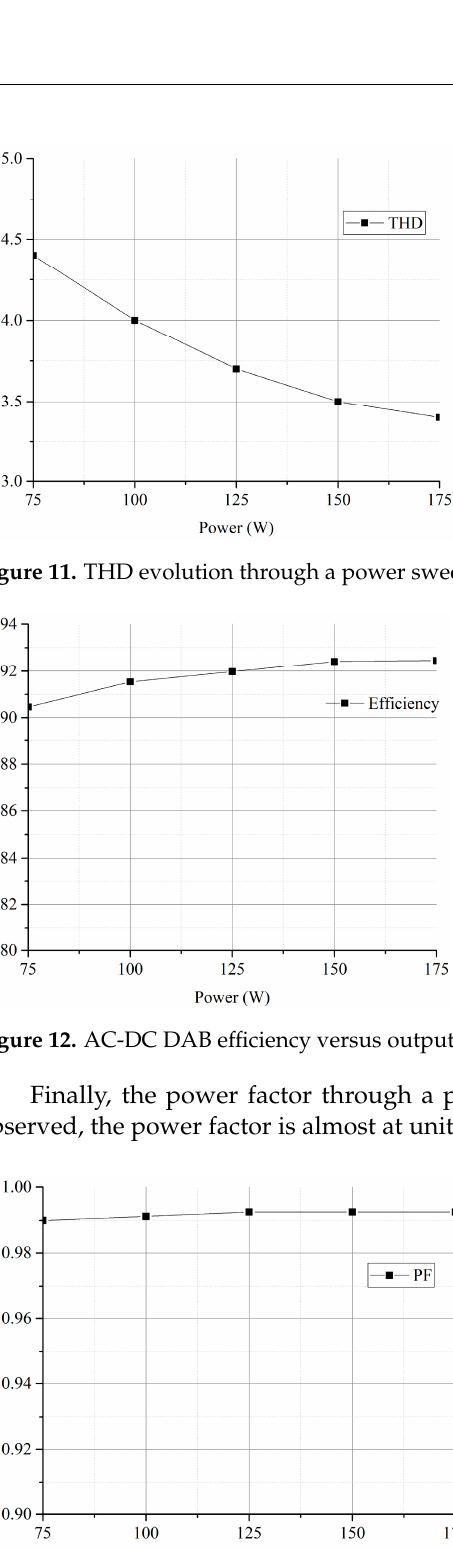
Figure 13. System power factor vs. output power.